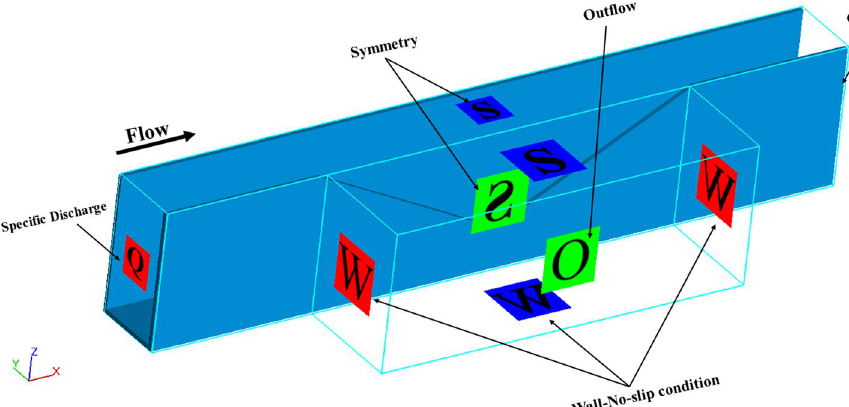
Fig. 2 Boundary condition labels for the TSCSW model